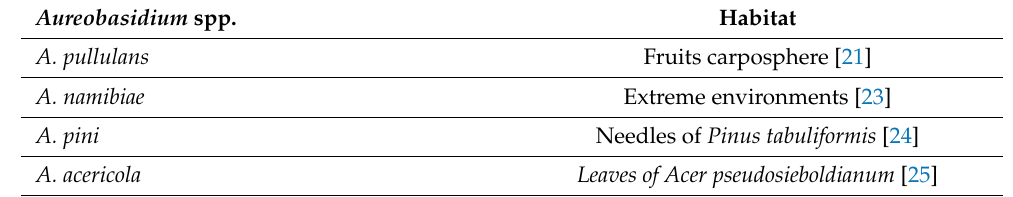
Table 1. Known and novel Aureobasidium spp. and the relative habitats. Aureobasidium